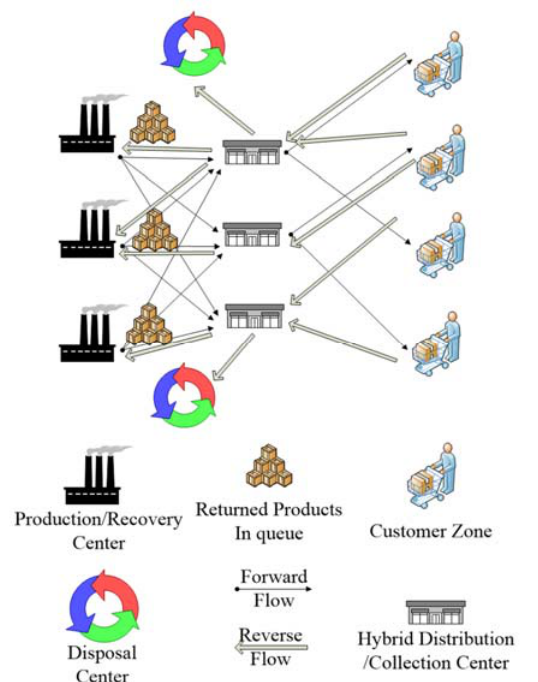
Fig. 1. Closed-loop supply chain with queueing systems in recovery